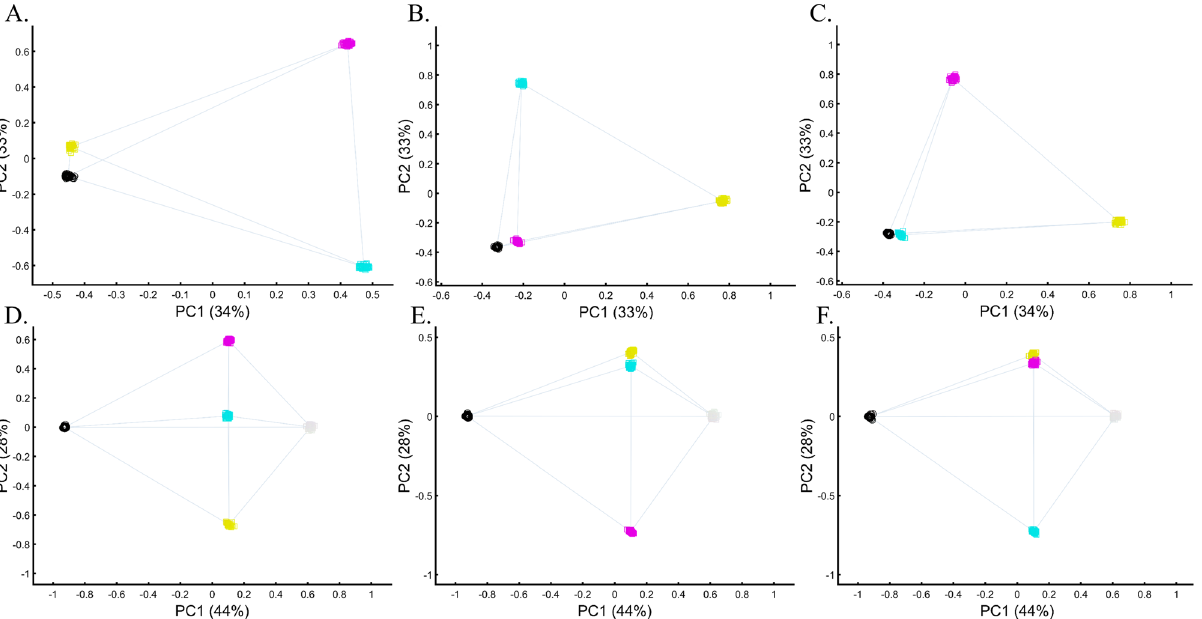
Figure 11. Studying the effects of minor sample variation on PCA results using color populations ( n all = 50). ( A – C ) Analyzing secondary colors and Black. ( D – E ) Analyzing secondary colors, White, and Black. Scatter plots show the top two PCs. Colors include Cyan [0,1,1], Purple [1,0,1], Yellow [1,1,0], White [1,1,0], and Black